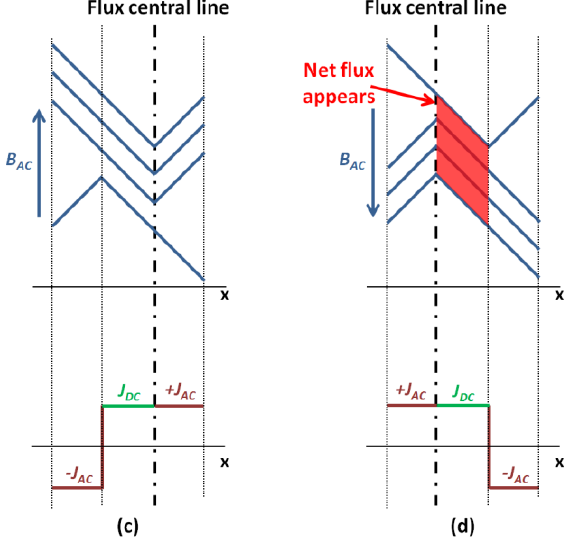
Figure 2. Magnetic field and current profiles of the superconducting slab in the presence of an AC magnetic field in the z direction: ( a , b ) the original Bean model (does not include the DC transport current) with no net flux, ( c , d ) Bean model with the add-up of a DC transport current in the y direction and the appearance of a net flux in the centre.